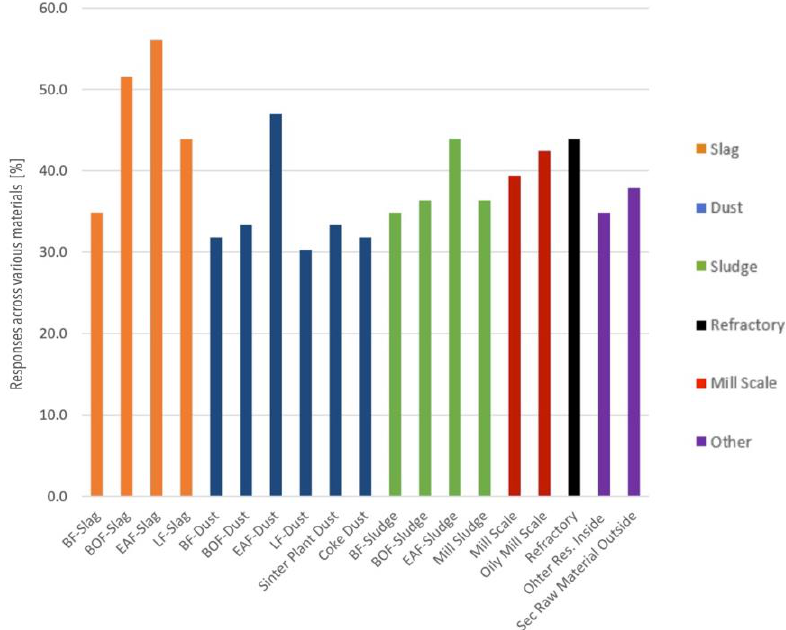
Figure 8. Responses providing an overview of research needs across by-products/residual materi- als [54].